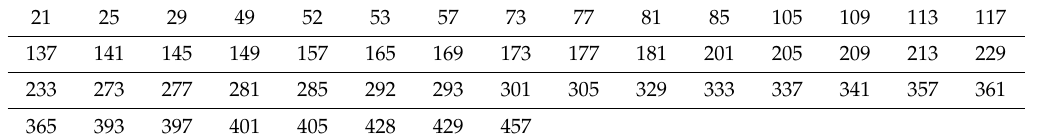
Table 13. x3 and x4 corresponding to block P texture template (decimal).